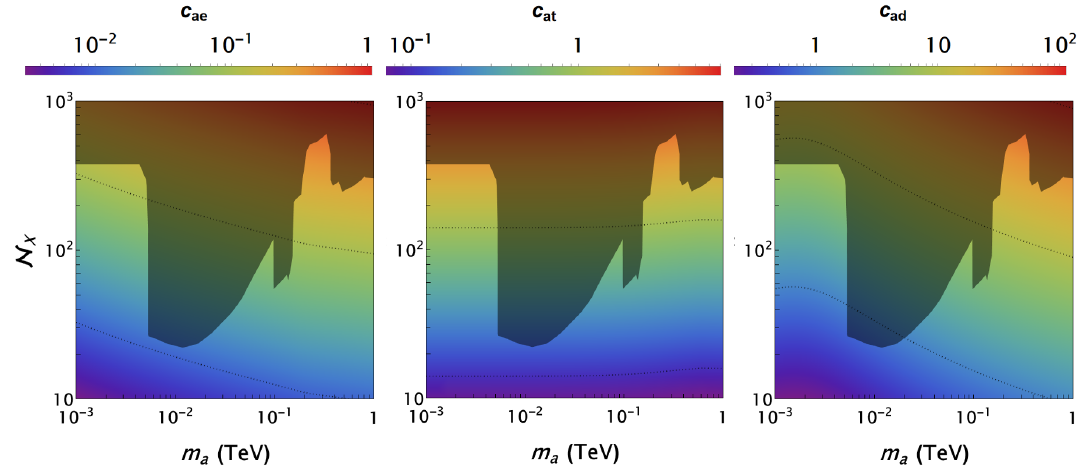
Figure 5 . Parameter space for a KSVZ-like ALP coupling with the same strength to all gauge bosons in the unbroken phase for v a = 1 TeV. The colour code shows the induced fermion coupling, with the electron, top and down from left to right. The shadowed region is excluded due to limits on the ALP coupling to photons [5, 45, 46]. The results in the m a ∼ 1 TeV should be taken carefully due to the possible non-validity of the EFT. The loop integrals were evaluated numerically using LoopTools [48,